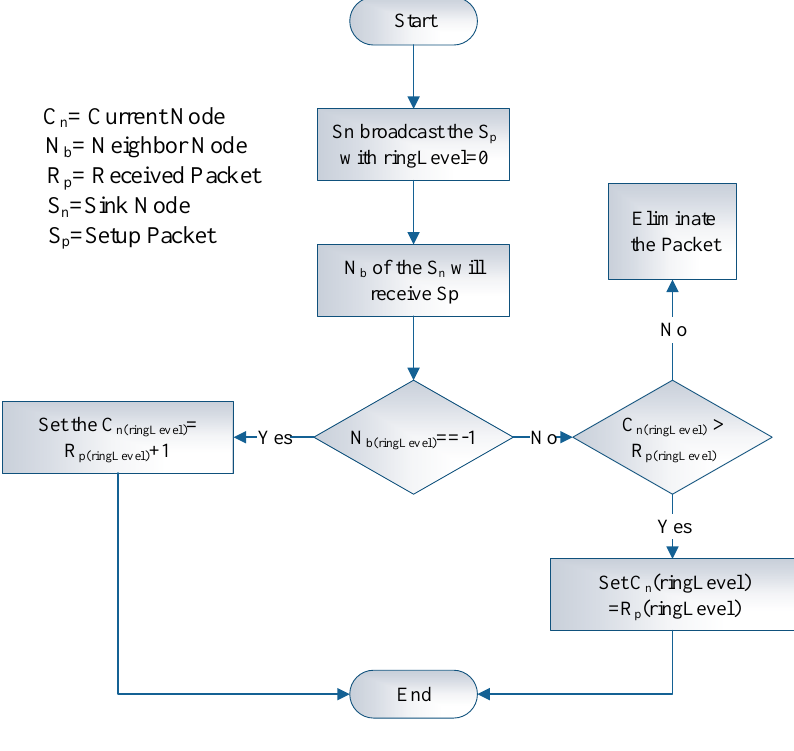
Figure 3. Initialization